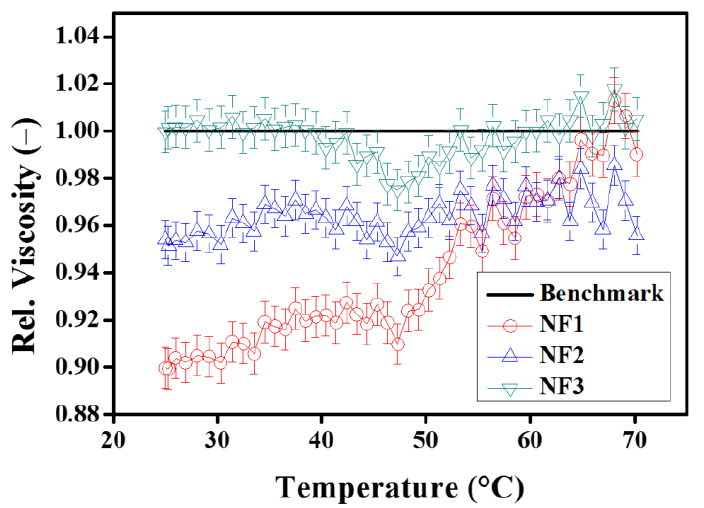
Figure 11. Relative viscosity as a function of temperature ramp in heating mode (25 – 70 °C) with pre- shear (50 s −1 ).